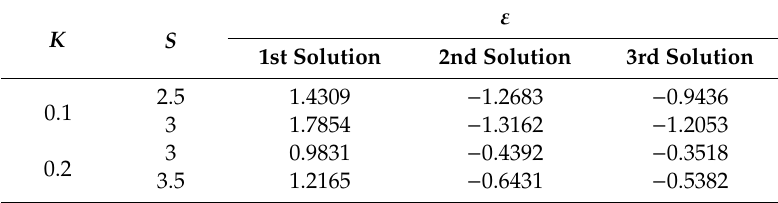
Table 1. Smallest eigenvalues for di ff erent values of K and S when M = 0.5, Pr = Sc = 1, m